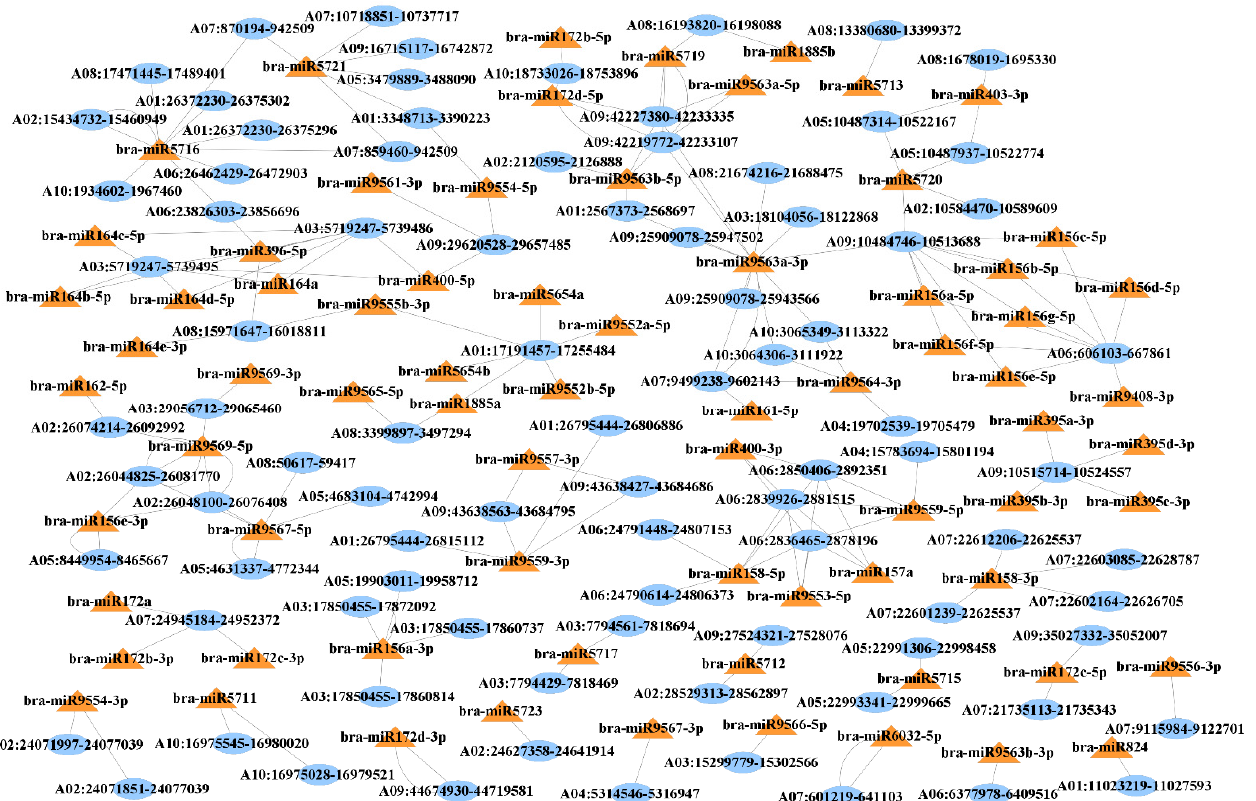
Figure 6. CircRNA–miRNA interaction network for differentially expressed circRNAs during pollen development in B. rapa . Blue ovals: circRNA IDs, orange triangles: miRNA IDs.